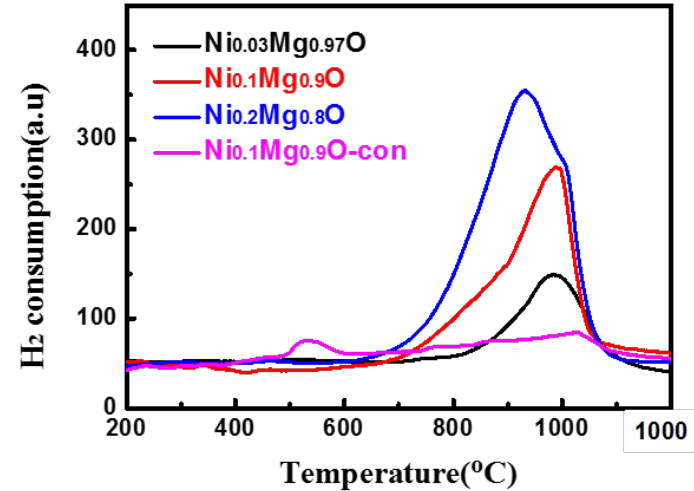
Figure 5. H 2 -TPR (H 2 temperature-programmed reduction) profiles of the Ni 0.03 Mg 0.97 O, Ni 0.1 Mg 0.9 O, Ni 0.2 Mg 0.8 O, and Ni 0.1 Mg 0.9 O-con catalysts. 146